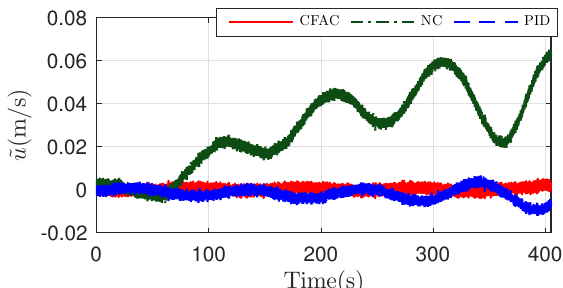
Figure 30. Velocity tracking error in virtual